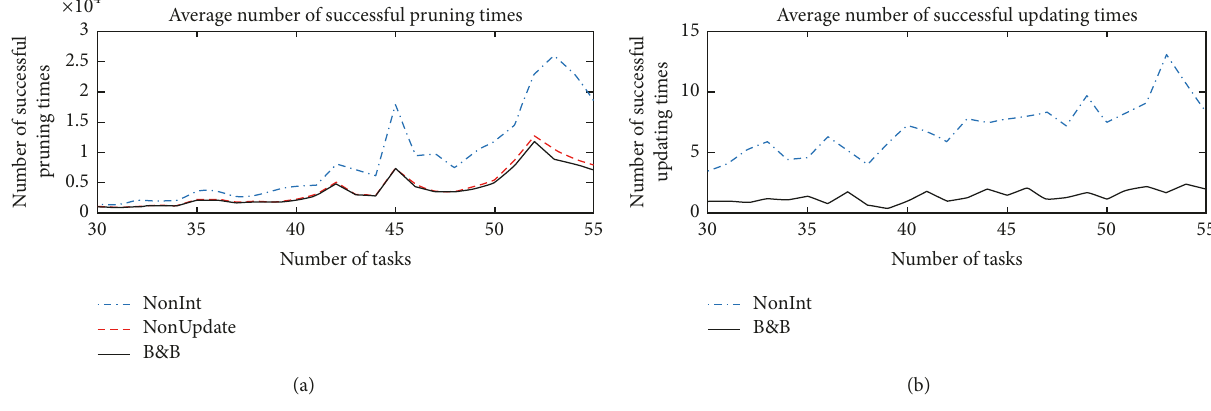
Figure 9: The number of successful pruning and updating